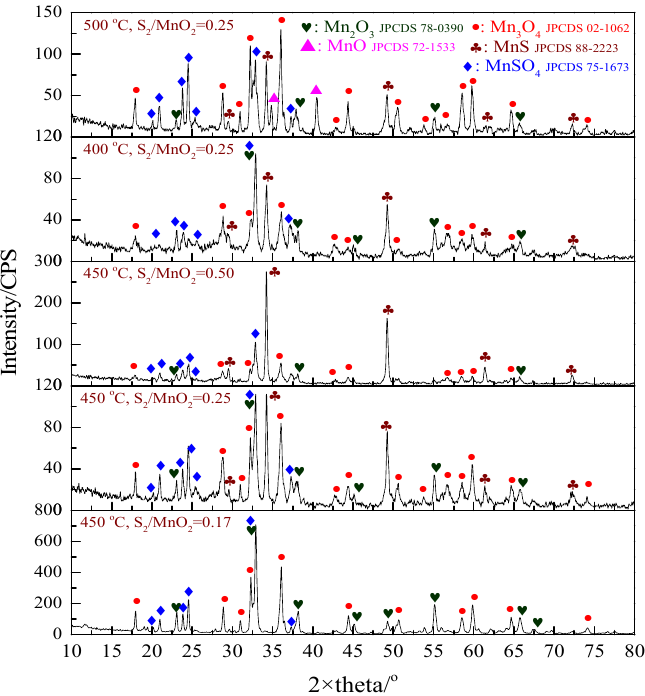
Figure 6. XRD patterns of roasted products as functions of roasting temperature and S 2 /MnO 2 molar ratio (roasting time: 30 min).